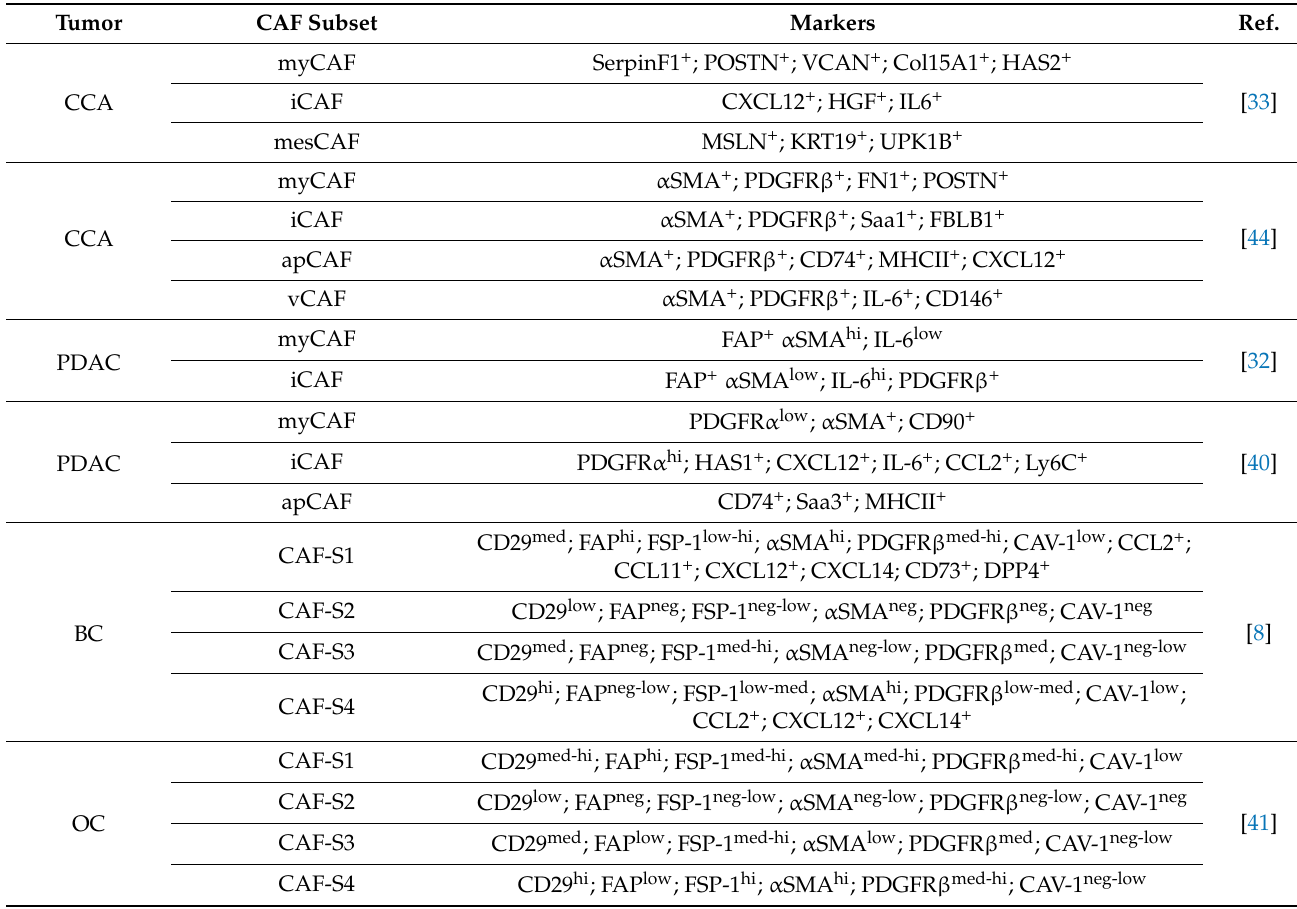
Figure 1. Overview of cholangiocarcinoma microenvironment and the main cancer-associated fibroblast subsets. Table 1. Summary of CAF subsets and their markers found in different tumors.